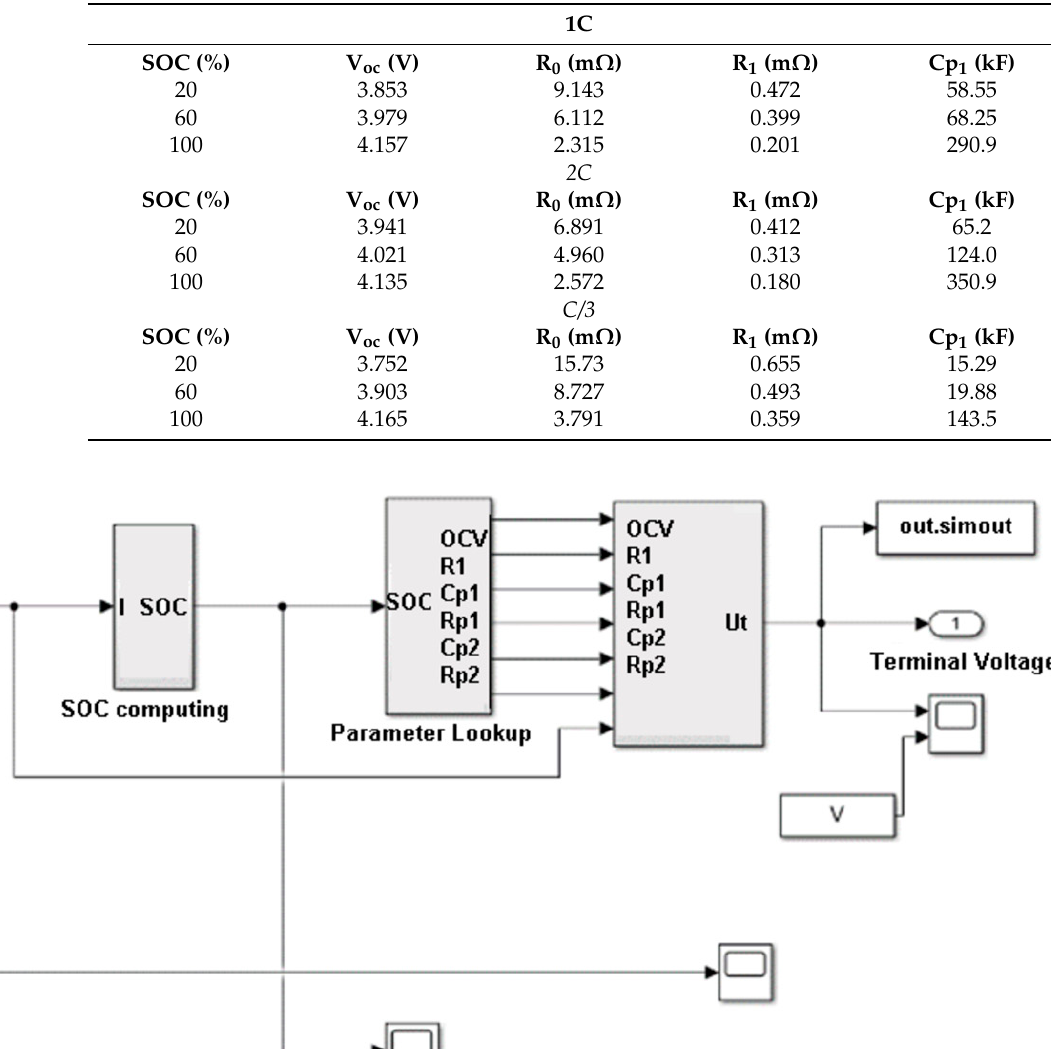
Table 1. Estimated parameters—First order Th é venin model.